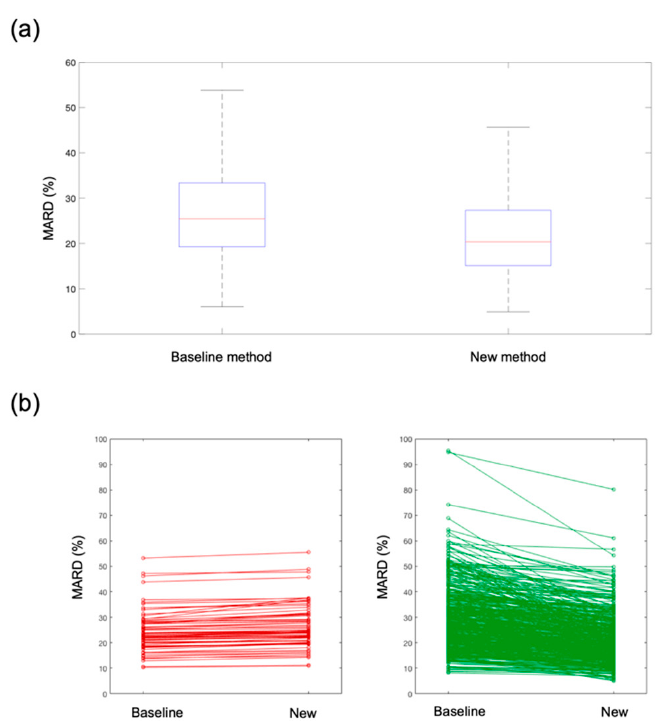
Figure 4. ( a ) Boxplot of MARD distributions in the population when using the baseline method (left boxplot) and the new method (right boxplot); ( b ) change in MARD for each single run when using the baseline and the new method. Left plot: runs with a MARD deterioration (~5% of the runs). Right plot: runs with a MARD improvement respect to the baseline method (~95% of the runs).